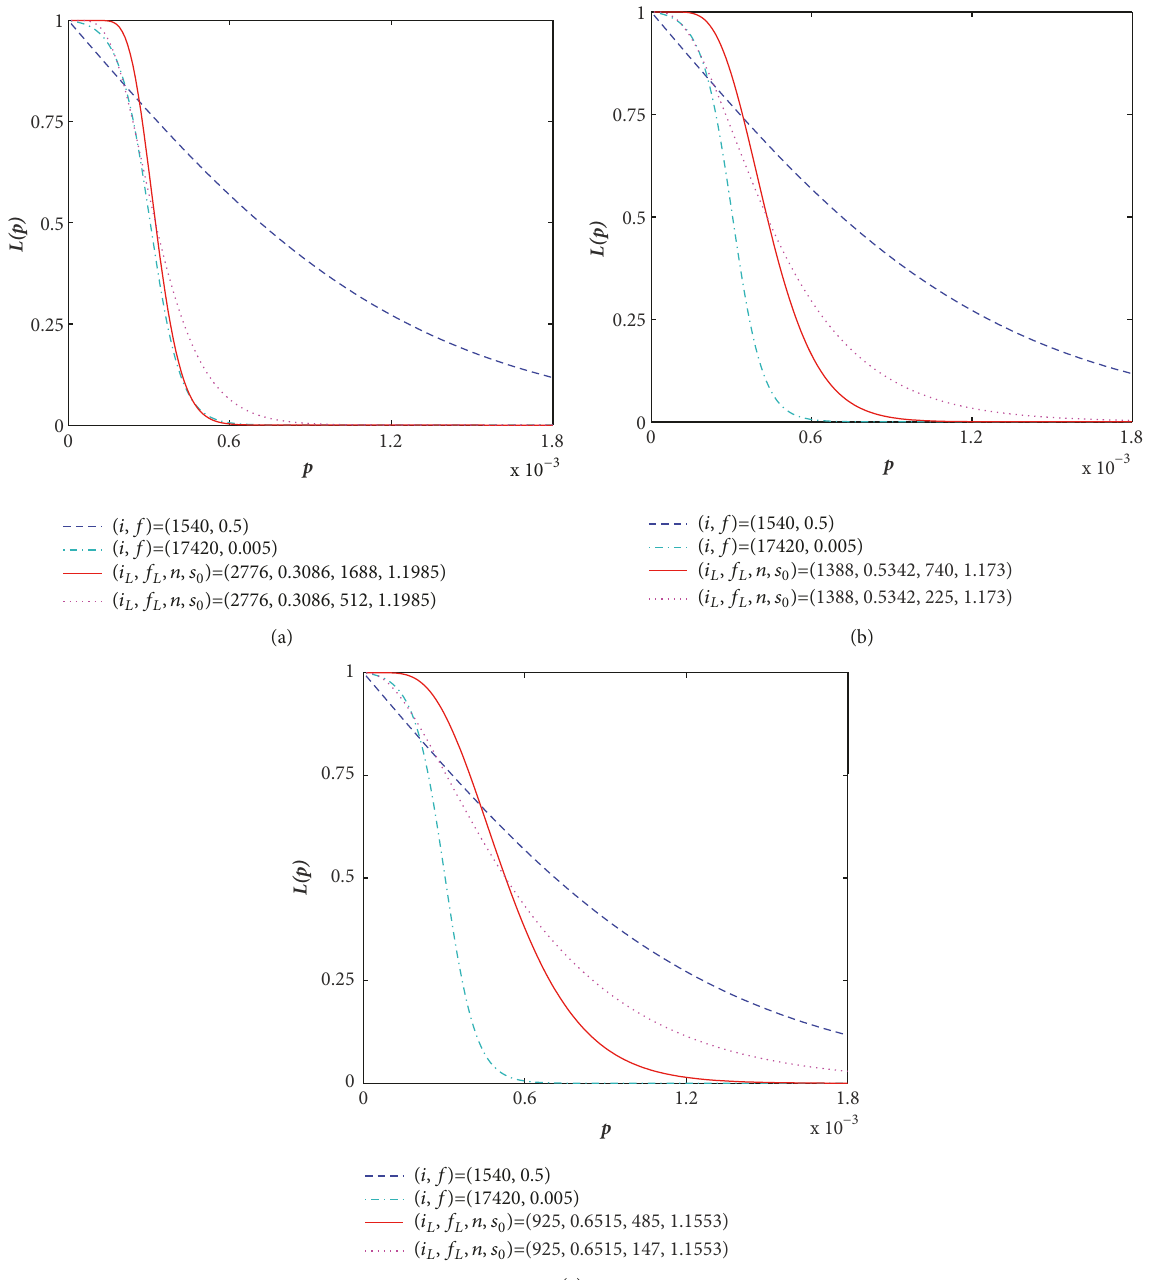
Figure 2: Comparisons of OC curvesfor the optimal schemesand inspection schemesin CSP-1 under AOQL = 0.00018 (a)at 𝐴𝐹𝐼 𝐿 = 0.6667 , (b) at 𝐴𝐹𝐼 𝐿 = 0.8 , and (c) at 𝐴𝐹𝐼 𝐿 = 0.8571